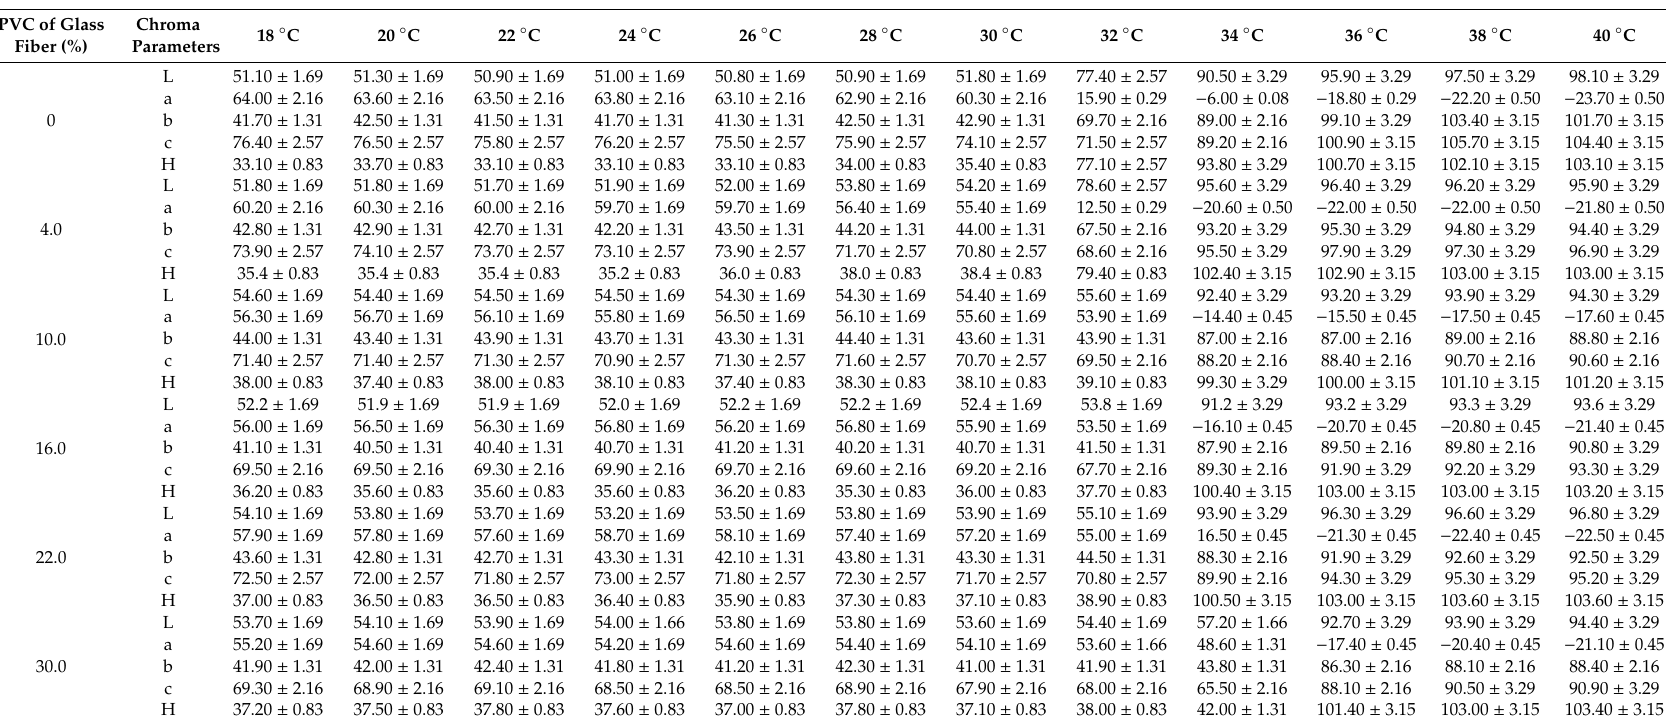
Table 2. Influence of pigment volume concentration (PVC) of glass fiber powder on the chroma change of the thermochromic waterborne coatings from 18 to 40 ◦ C. PVC of Glass Fiber